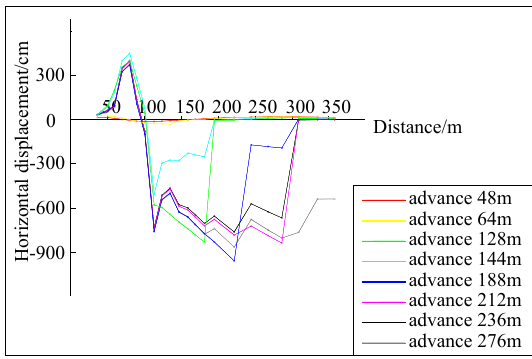
Figure 22. Horizontal displacement curve.